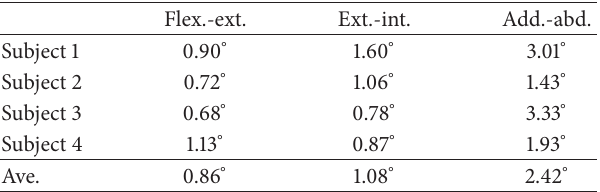
Table 2: Standard errors of measurements of the knee angle in the stance phase of each subject. Flex.-ext.